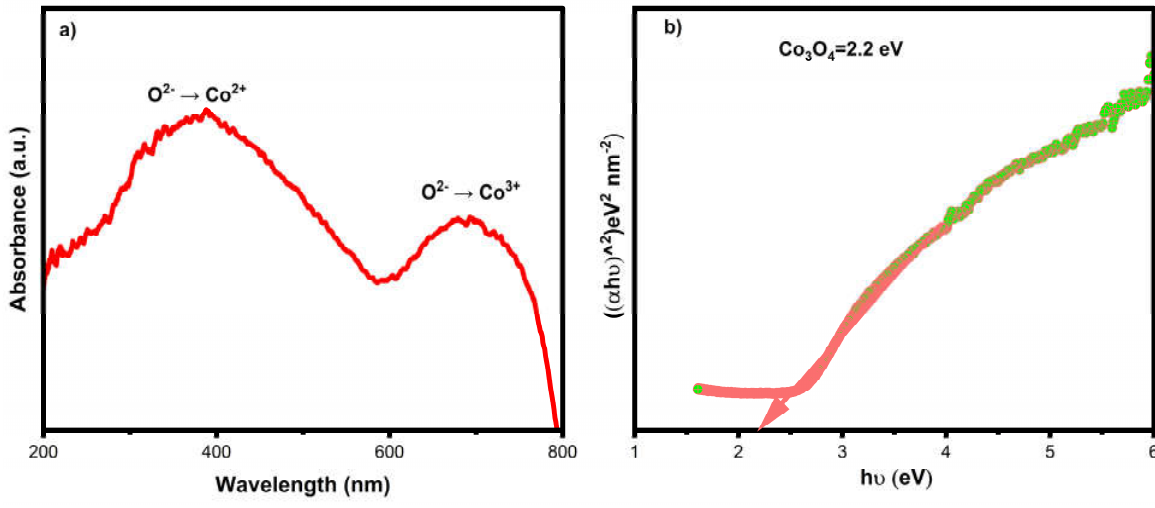
Figure 3. UV-DRS absorbance ( a ) and bandgap energy ( b ) spectrum of Co 3 O 4